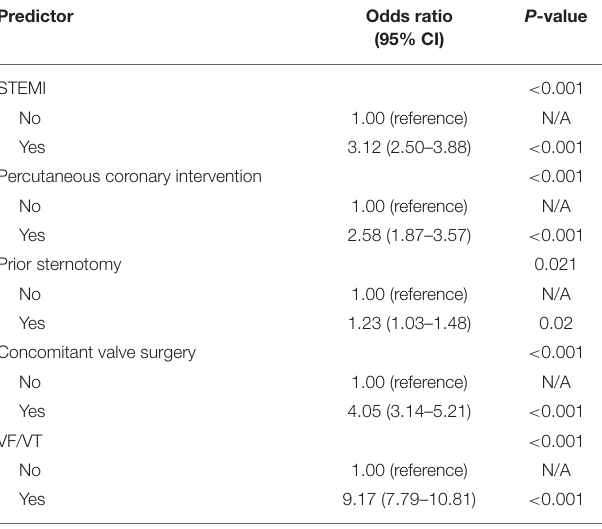
TABLE 3 | Univariate analysis for predictors of in-hospital mortality, 2015–2016.